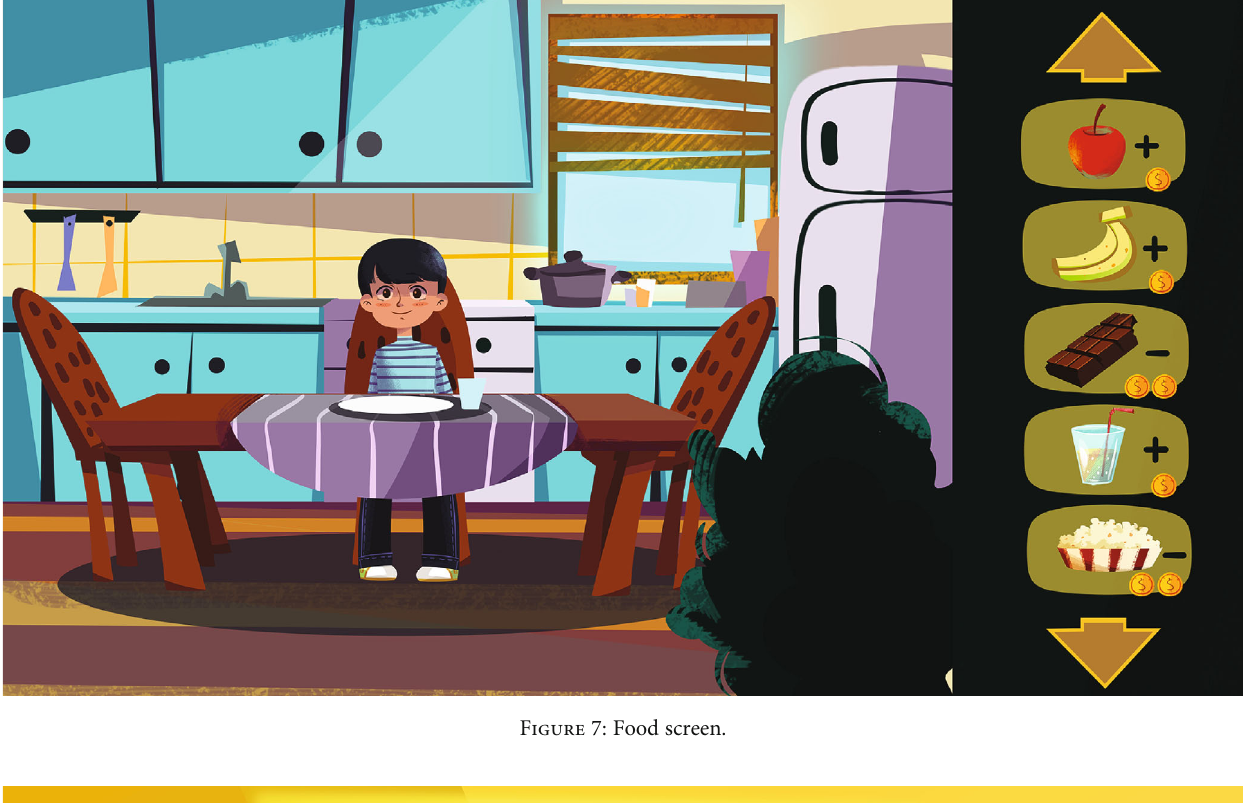
Figure 7: Food screen.